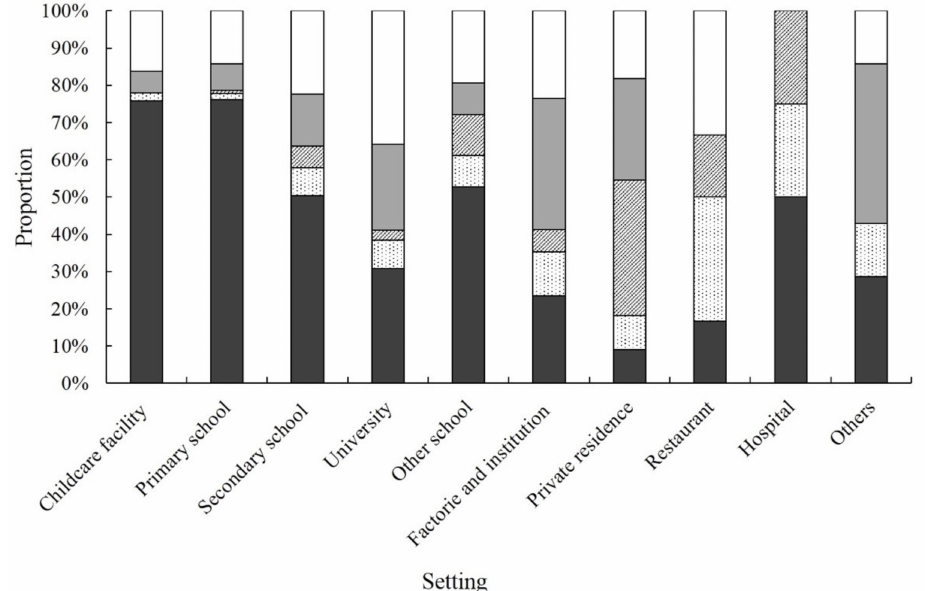
Figure 3. Percentage of norovirus outbreaks by setting attributed to transmission mode, China,